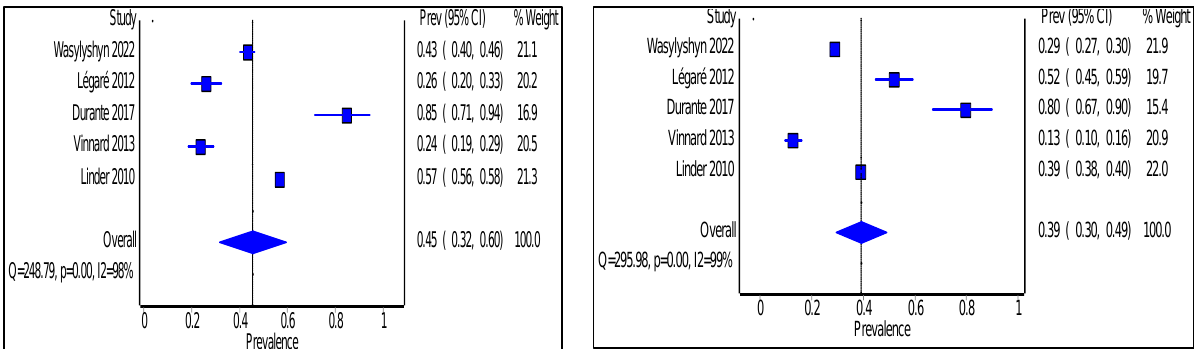
Figure 8. Prevalence of patients prescribed antibiotics in accordance with hospital guidelines within the outpatient setting in the non-intervention and intervention groups.